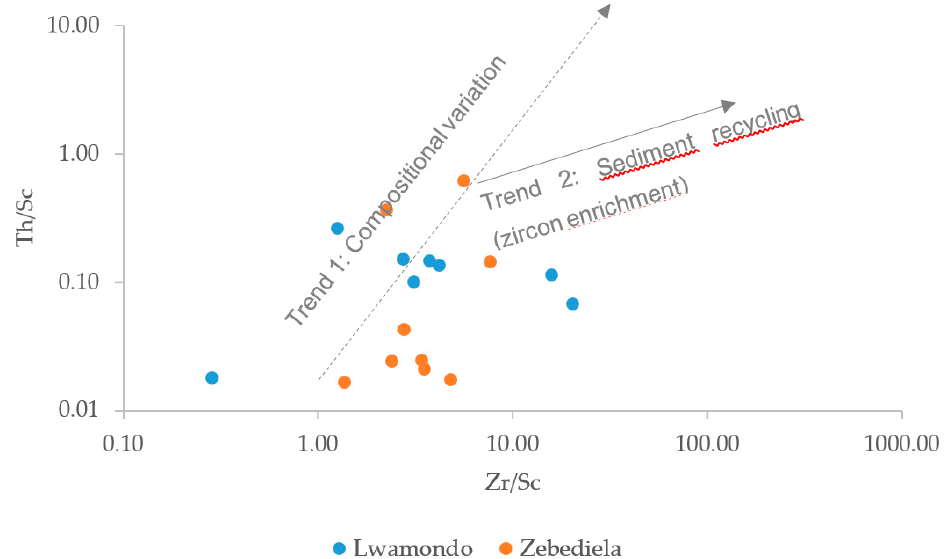
Figure 11. Th/Sc vs. Zr/Sc plot showing the normal trend for compositional variation in the Lwamondo and Zebediela kaolins.